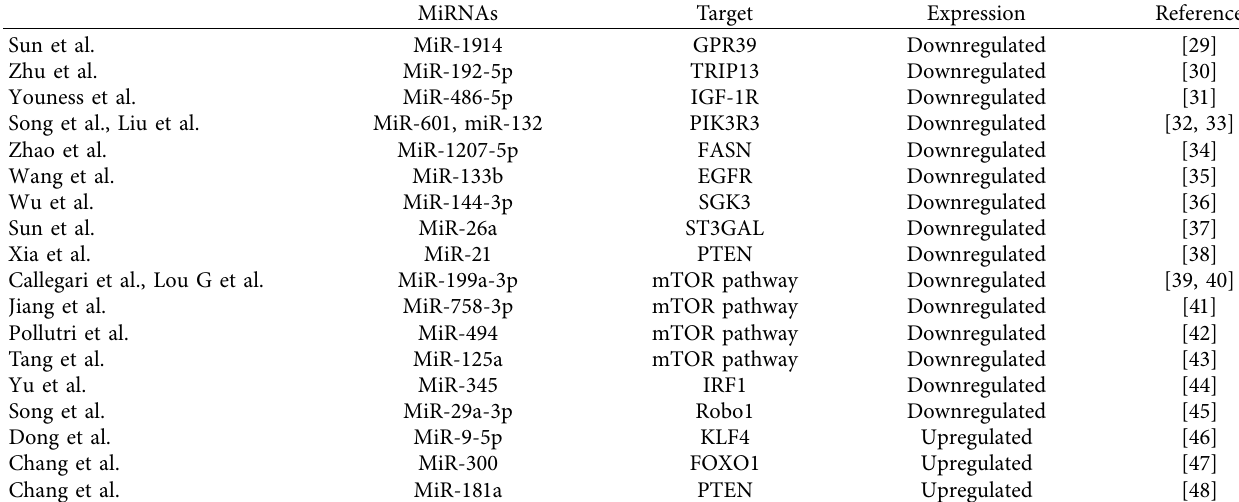
Table 1: Dysregulated miRNAs in